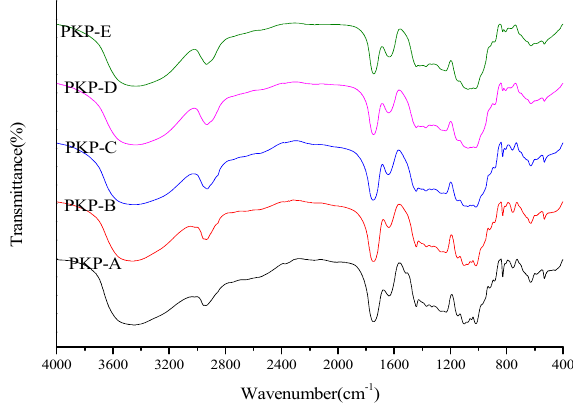
Figure 2. FT-IR spectra of the five PKPs.